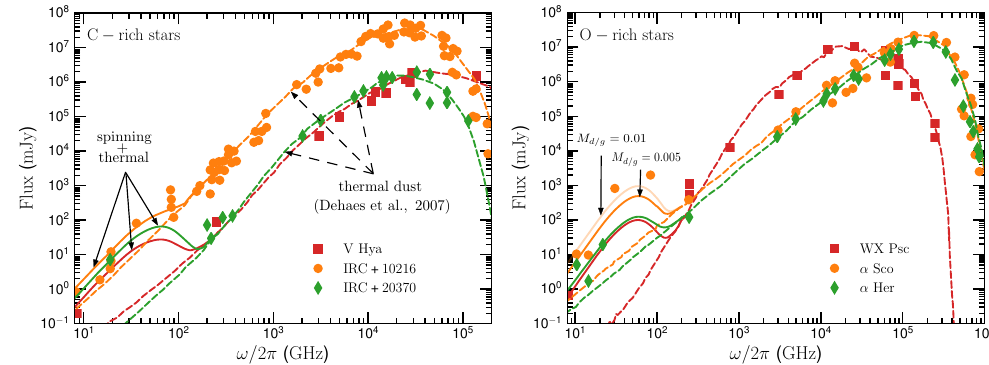
Figure 25. Comparison of spinning dust (solid lines, this work) and thermal dust (dashed lines, taken from Dehaes et al. [128]) model to radio observational data from the literature (filled symbols). The solid lines show that the spinning dust model can reproduce well the CSEs of both C-rich (left panel) and O-rich stars (right panel). C-rich stars - S max 10 10 ergcm − 3 , β = 0.4D: η = 3.7 (IRC + 10216), ≥ − η = 3.6 (IRC + 20370) and η = 3.2 (V Hy α ). O-rich stars - S max 10 9 ergcm − 3 : β = 2.3D, η = 5.0 − − ≥ − ( α Sco); β = 1.6D, η 4.4 ( α Her); β = 1.2D, η = 4.8 (WX Psc). Note: the dust-to-gas mass ratio ∼ − − is fixed as M d / g = 0.005 as in Dehaes et al. [128]. The faint orange line likely indicates a